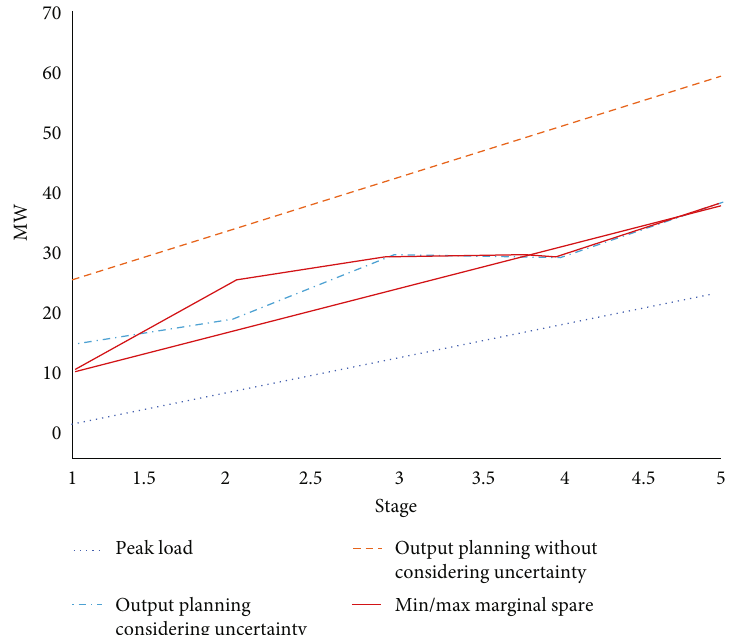
Figure 4: Comparison of power reduction results of A5 units in scenario 1 and scenario 2 under the condition of 10% reduction of wind farms.